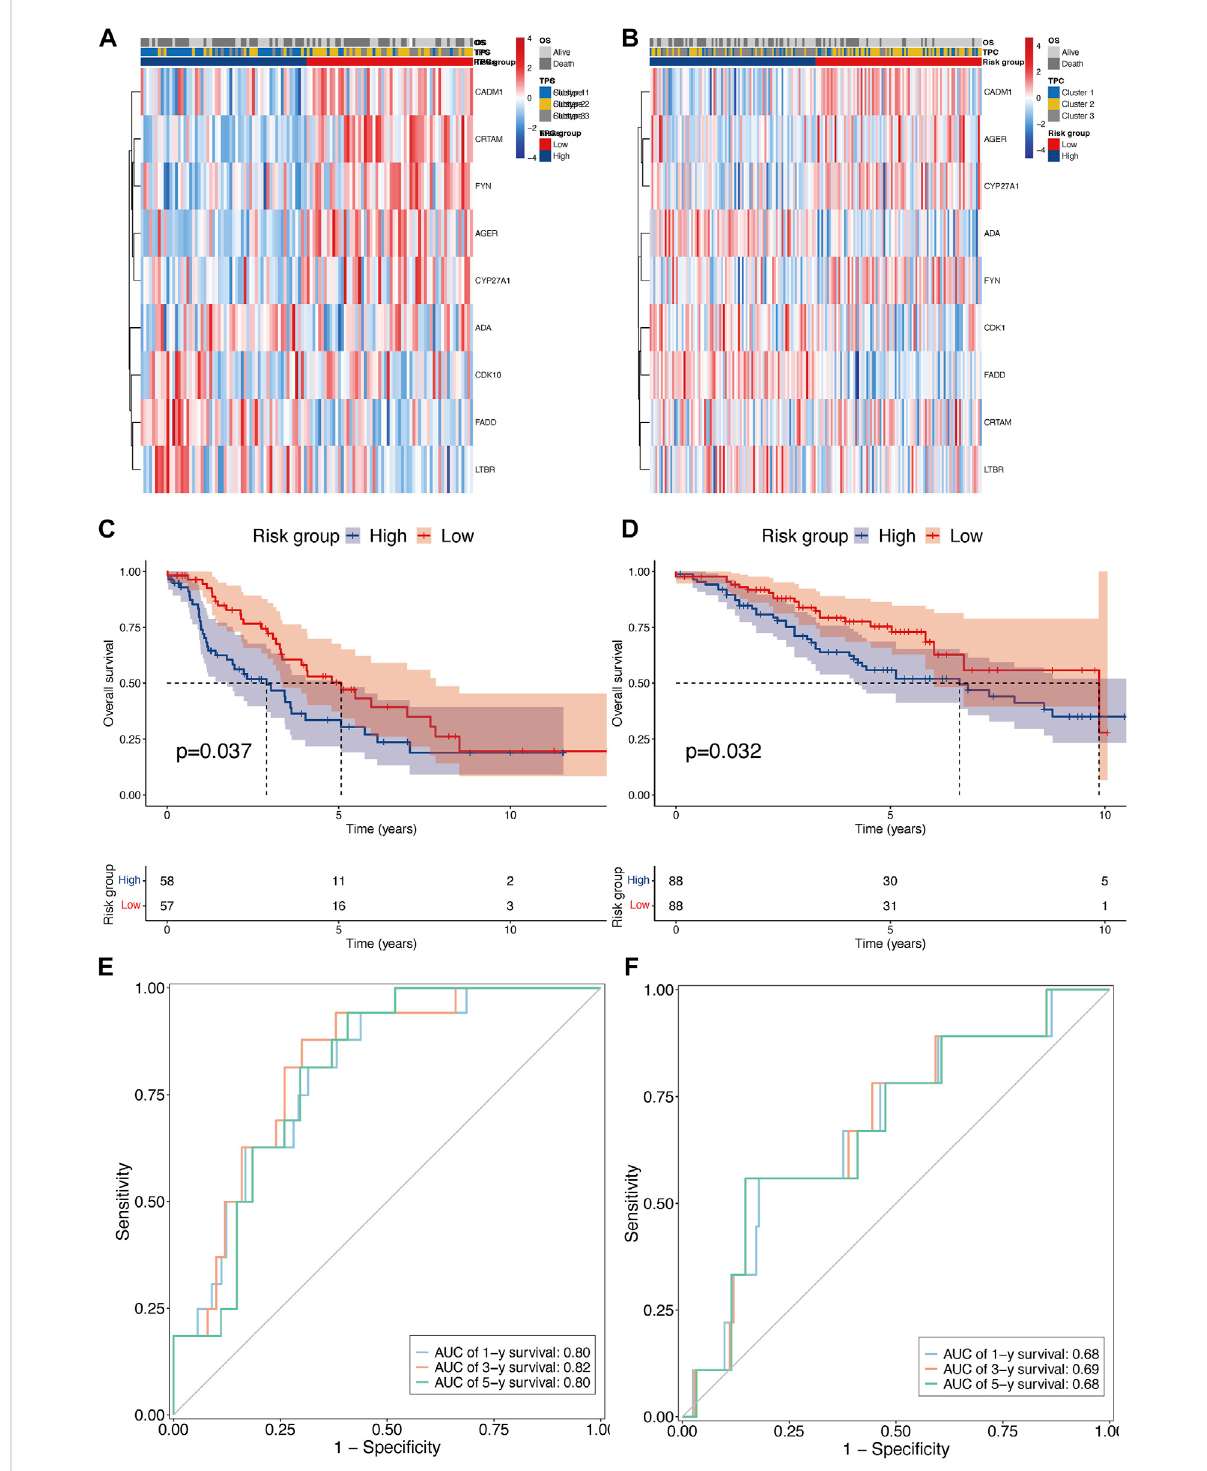
FIGURE 6 External validation of TPR signature in GSE42127 and GSE36471 cohorts. (A,B) Heatmap of nine TPR signature in external validate cohort (GSE36471 n = 115: left, and GSE42127 n = 176: right). (C,D) KM curves showing OS in patients with TPR signature (Left: GSE36471, and right: GSE42127). (E,F) AUC curves of 1 (light blue), 3 (orange), and 5 years (green) in both external cohorts (Left: GSE36471, and right: